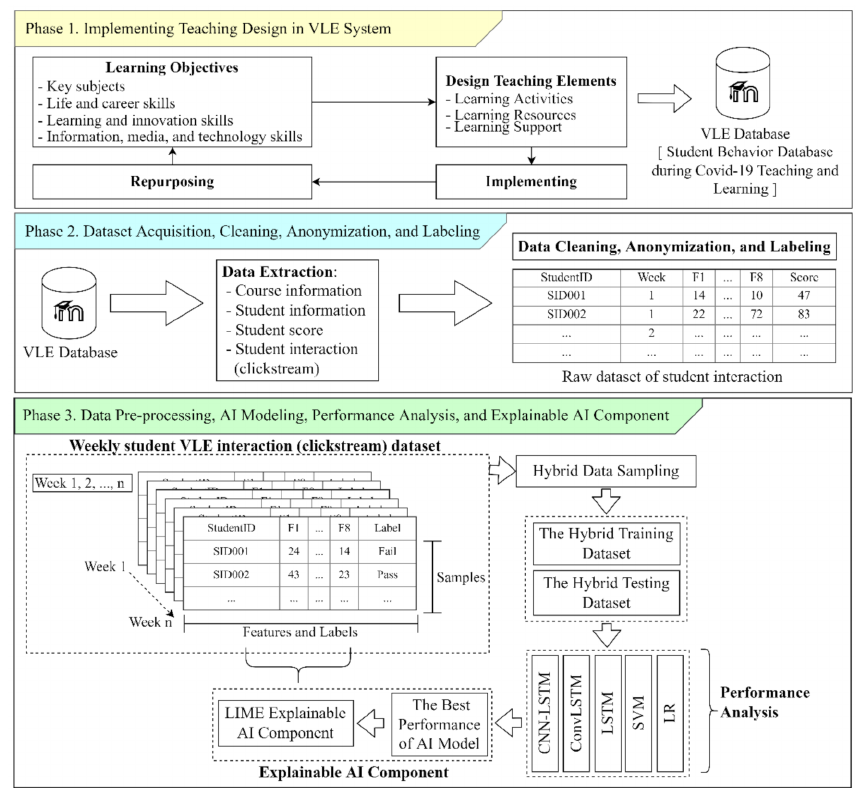
Figure 1. The proposed framework of ESPP. An Intelligent Framework for Explainable Student Per- formance Prediction consisted of three phases: (1) Implementing Teaching Design in VLE System; (2) Dataset Acquisition, Cleaning, Anonymization, and Labeling; (3) Data Pre-processing, AI Modeling, Performance Analysis, and Explainable AI Component.